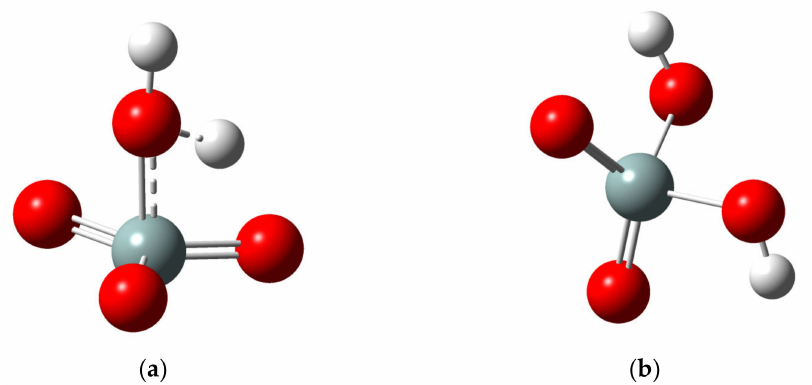
Figure 3. Quantum calculations for reaction of H 2 O with SiO 3 molecule. ( a ) Initial configuration ( b ) final